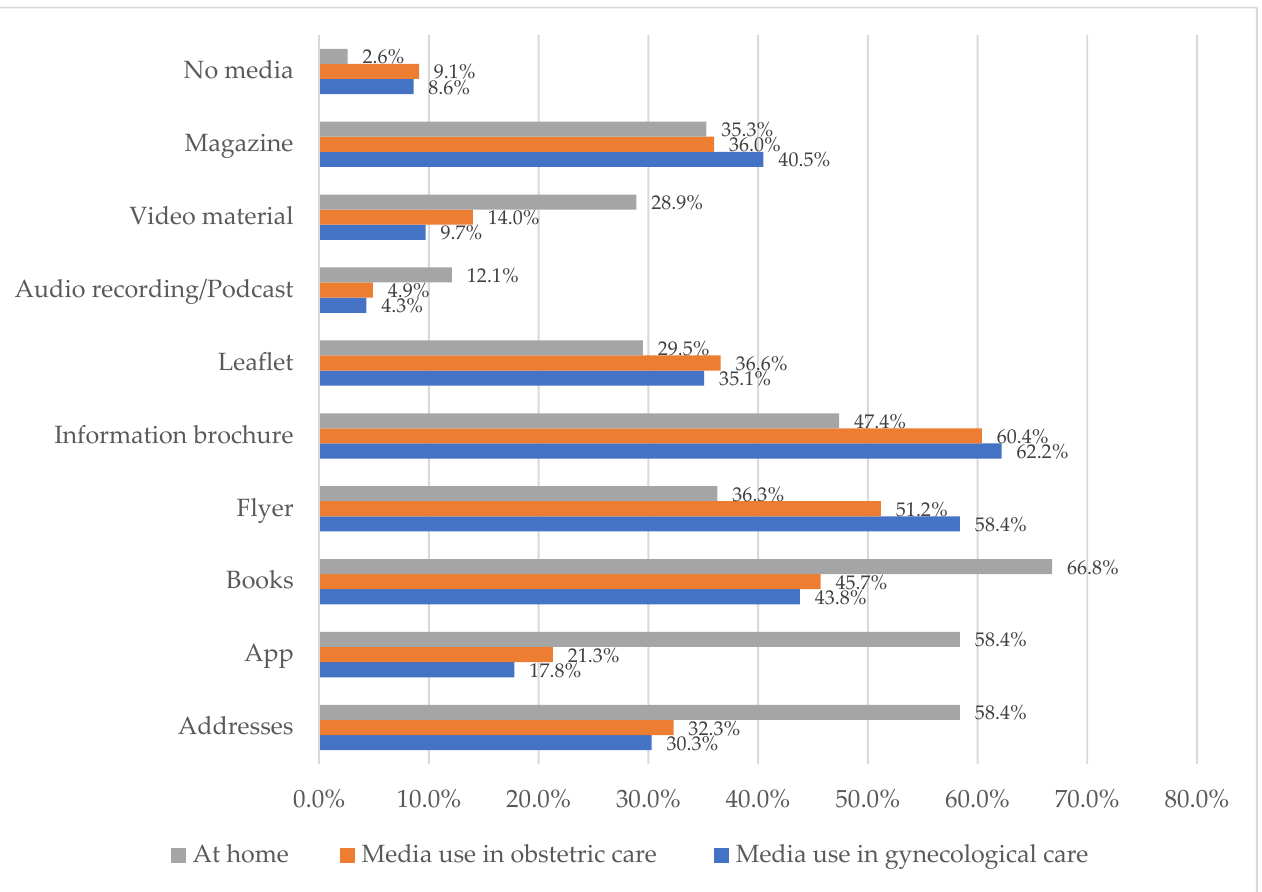
Figure 2. Women’s preferred media formats regarding health-related behaviors during pregnancy and lactation in gynecological and obstetric care (N = 219).